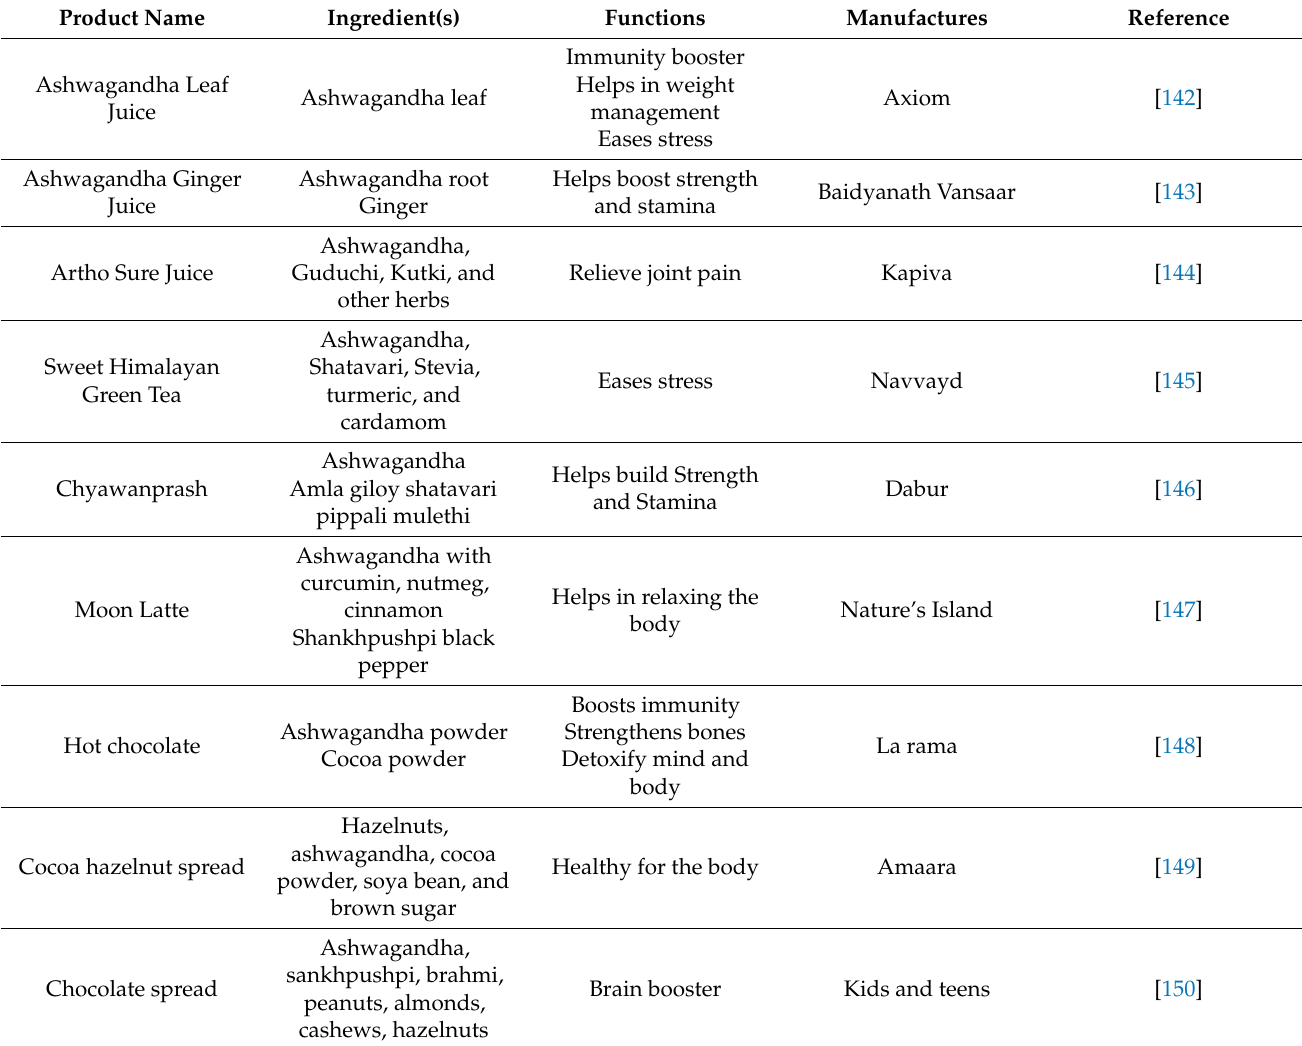
Table 9. Different manufactures marketing Withania -based formulations in food